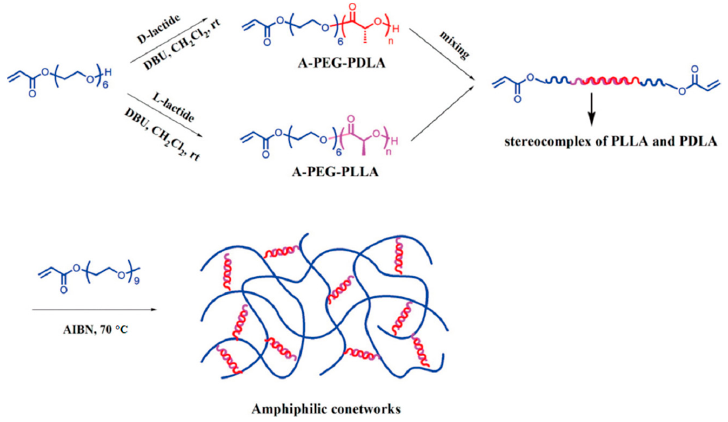
Figure 8. Illustration of amphiphilic conetworks synthesis by polylactide (PLA) stereocomplex. Reprinted from [70]. Copyright (2013) American Chemical Society.